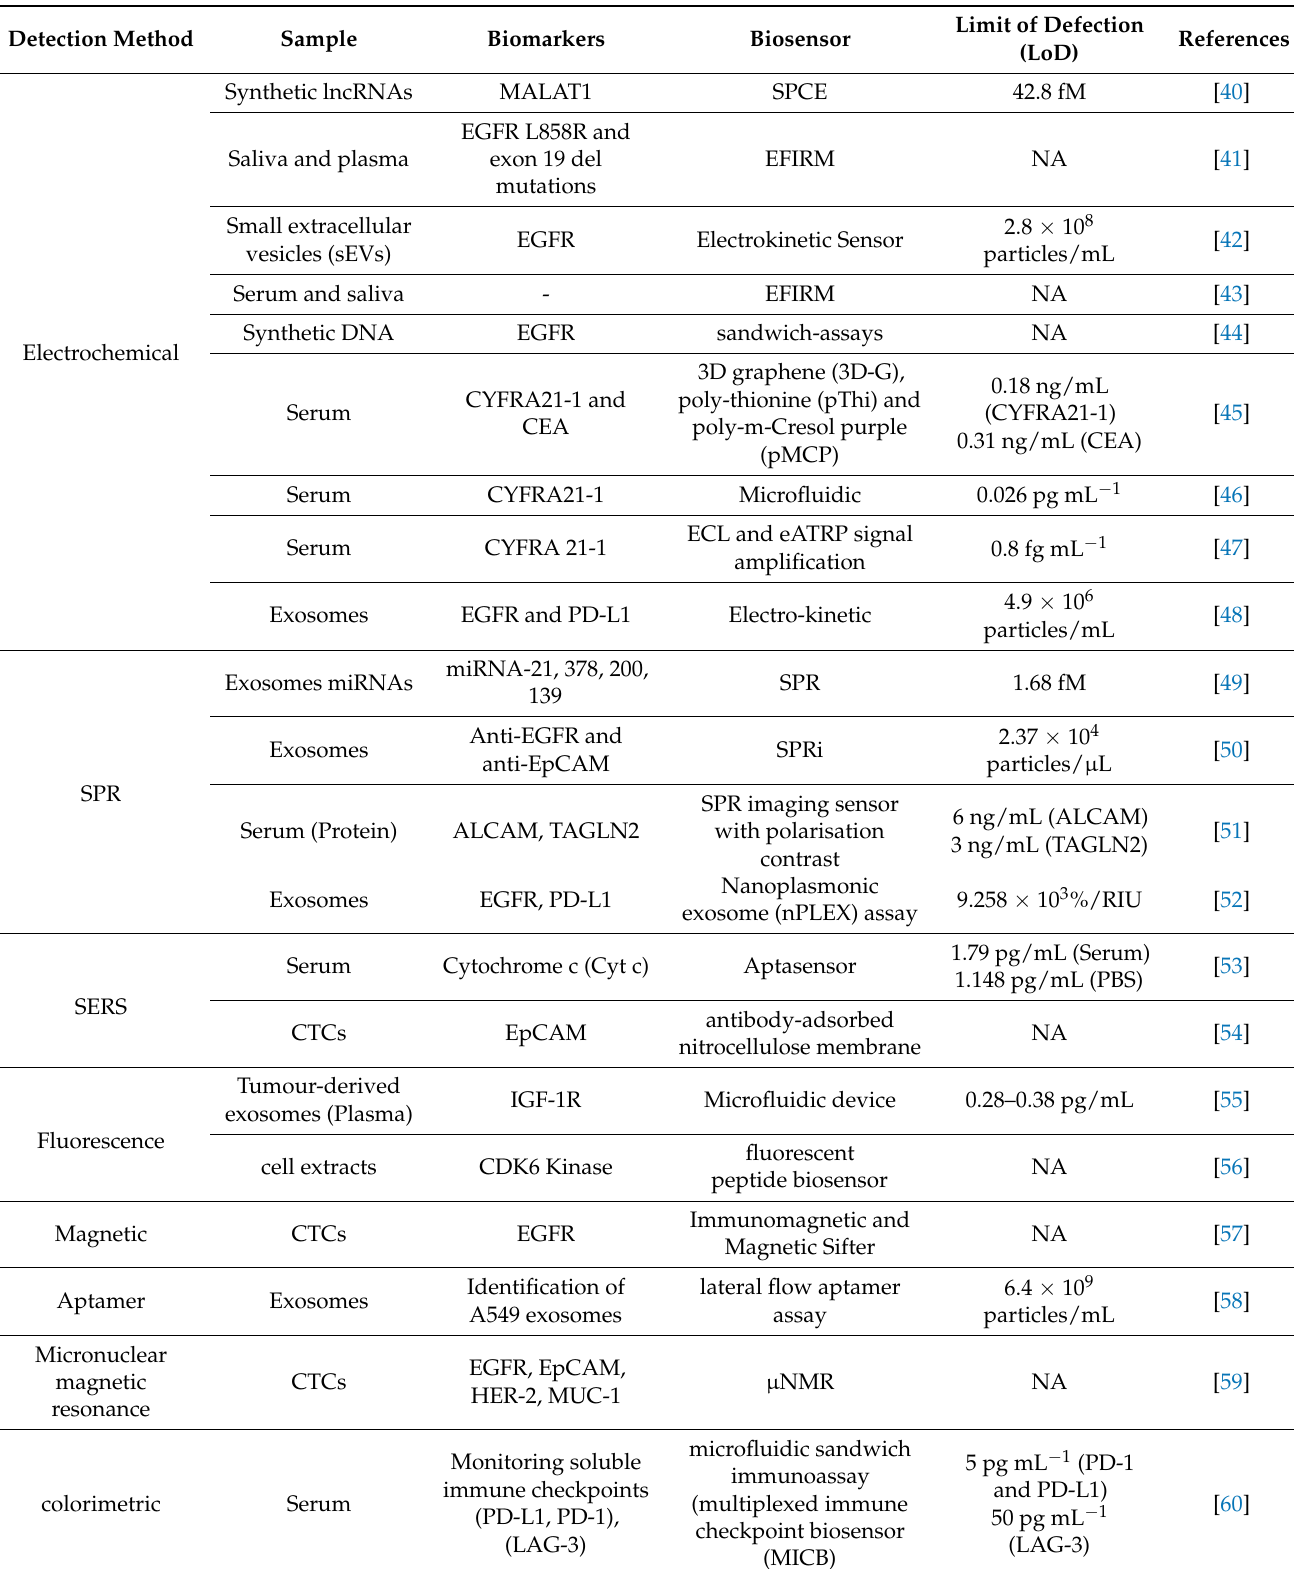
Table 2. A classification of biosensors for lung cancer